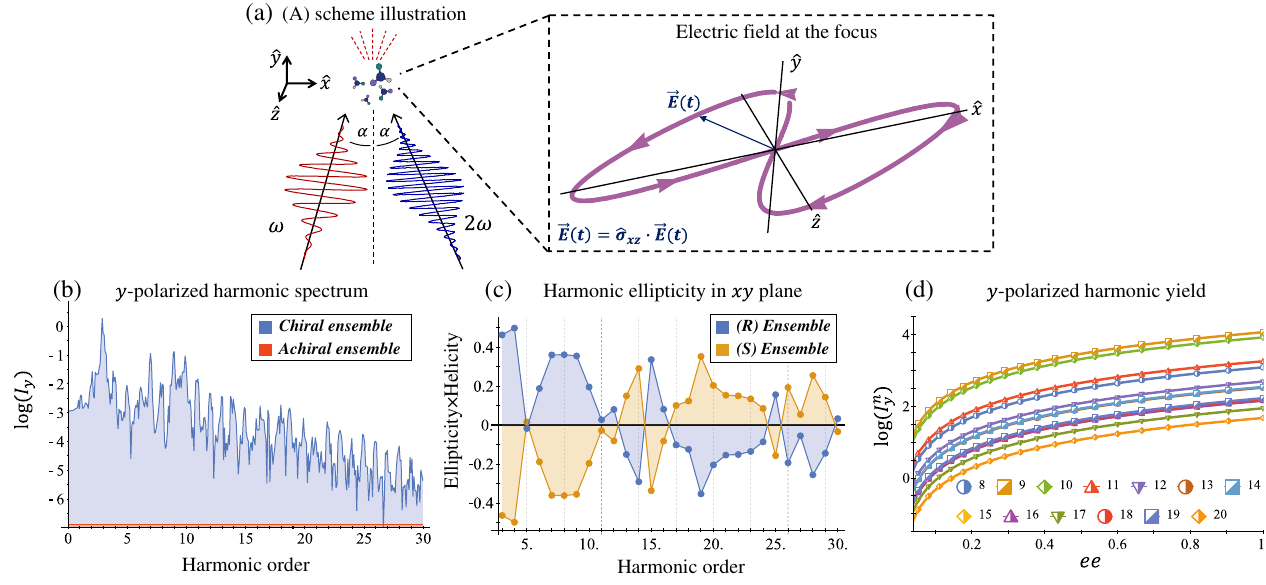
FIG. 1. Static reflection symmetry-breaking-based chirality detection in HHG: Numerical model potential results. (a) Illustration of scheme (A) with the pump field from Eq. (7). The inset shows the 3D Lissajou plot of the microscopic electric field vector in the focus (though, in this case, the field is 2D and is contained in the xz plane), which exhibits a static reflection symmetry (arrows along the Lissajou represent the direction of time). (b) Numerically calculated y -polarized HHG emission from the chiral and achiral ensembles 6 . 5 × 10 13 W = cm 2 , ϕ ¼ 0 , Δ ¼ 1 , α ¼ 15 0 , and a trapezoidal envelope with four- ( ψ 6 in model potential) for λ ¼ 900 nm, I max ¼ optical-cycle long turn-on/off and four-optical-cycle long flattop. In the chiral ensemble, all harmonic orders have y -polarized components (both even and odd), while there is no y -polarized harmonic emission from the achiral ensemble. (c) Calculated harmonic ellipticities in the xy plane from (R) and (S) ensembles — the helicity changes sign with the medium ’ s handedness. (d) Integrated y -polarized yield per harmonics 8 – 20 vs ee in log